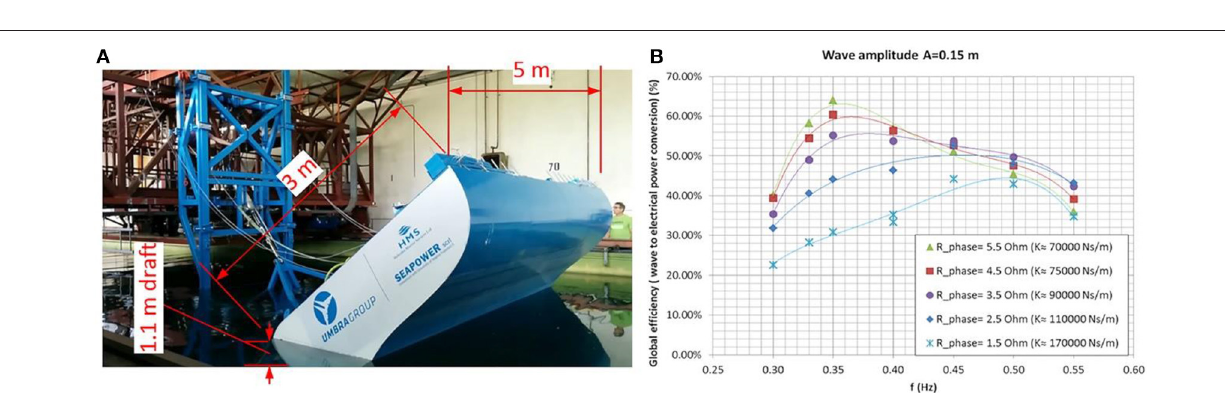
FIGURE 11 | Wave tank experimental test on large scale model (A) . Global conversion efficiency in regular wave tests, as a function of wave frequency for different electrical resistance load. Wave amplitude 0.15m (B)